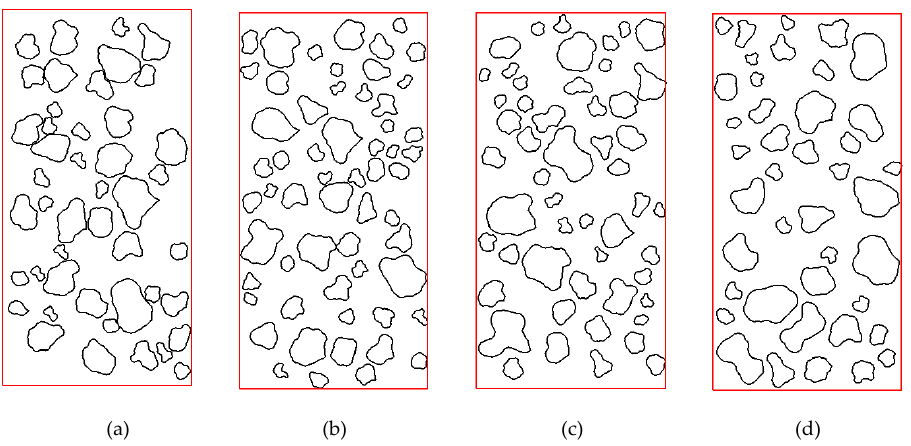
Figure 13. Granular mixture samples with different minimum coarse particle distances (cm): ( a ) d min = 0.0 cm; ( b ) d min = 0.05 cm; ( c ) d min = 0.10 cm; ( d ) d min = 0.20 cm.